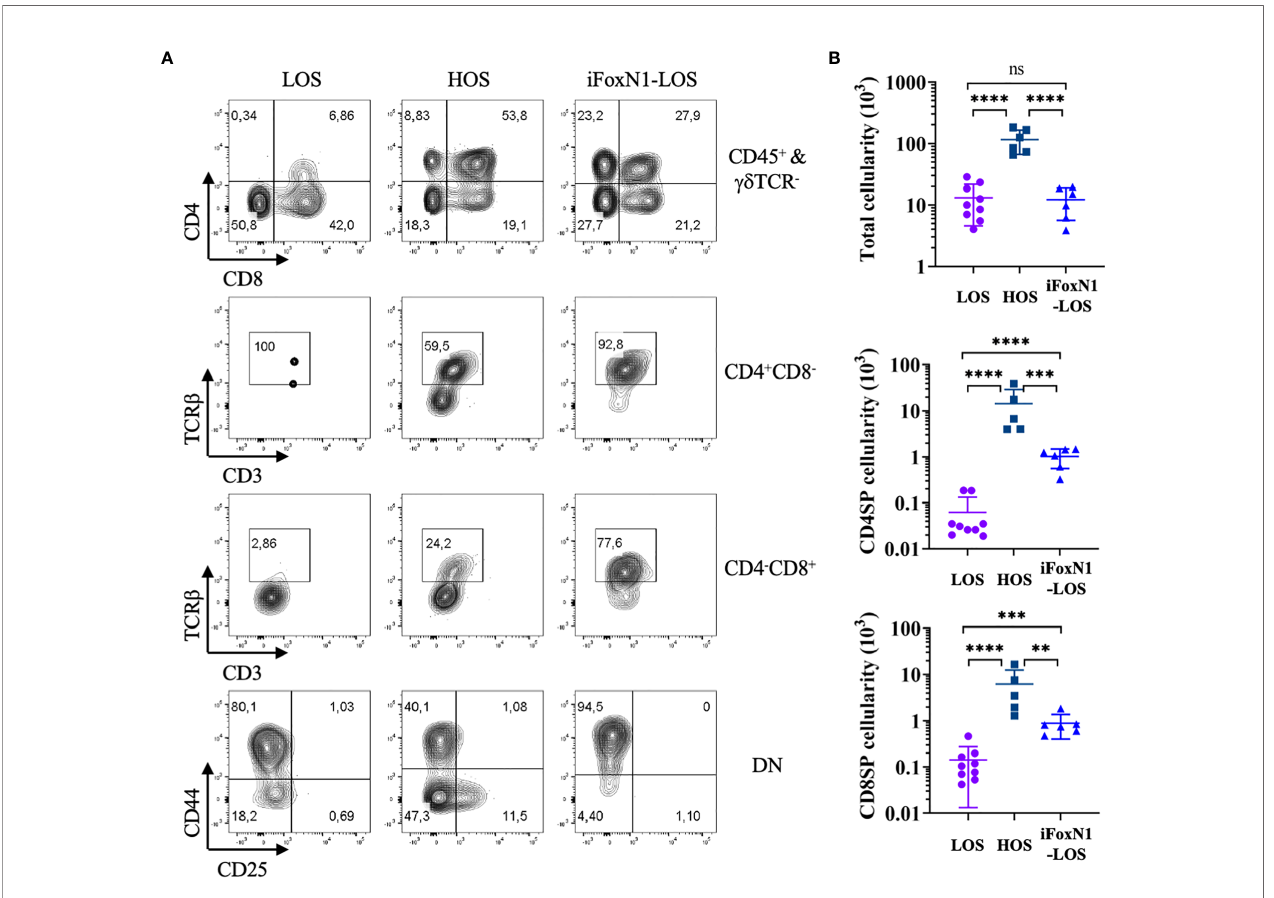
FIGURE 2 | Generation of ab T cells in HOS- and iFoxN1-LOS-FTOC. (A) Flow cytometric analysis of thymocytes from 8-day LOS, HOS, and iFoxN1-LOS cultures, as indicated. The top panels display CD4 and CD8 expression of CD45 + gd TCR - gated cells. The middle two panels display TCR b and CD3 expression of CD4 + CD8 − gated cells, and CD4 − CD8 + gated cells, respectively. The bottom panels display CD44 and CD25 expression of CD4 − CD8 − DN cells. (B) Scatter dot plots and statistical analysis (one-way ANOVA with post-hoc Tukey ’ s test) of total (top), CD4SP (middle), and CD8SP (bottom) cell numbers from 8-day cultures, as indicated. ns, not signi fi cant; p > 0.05; **p < 0.01; ***p < 0.001; ****p <